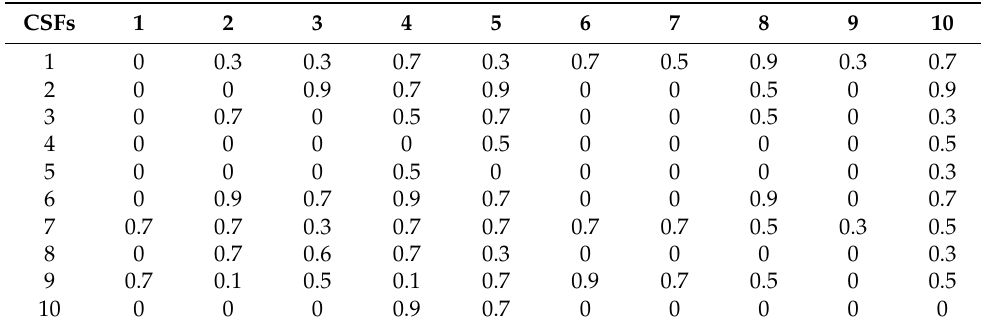
Table 6. FDRM of determinants of logistics 4.0 adoption.